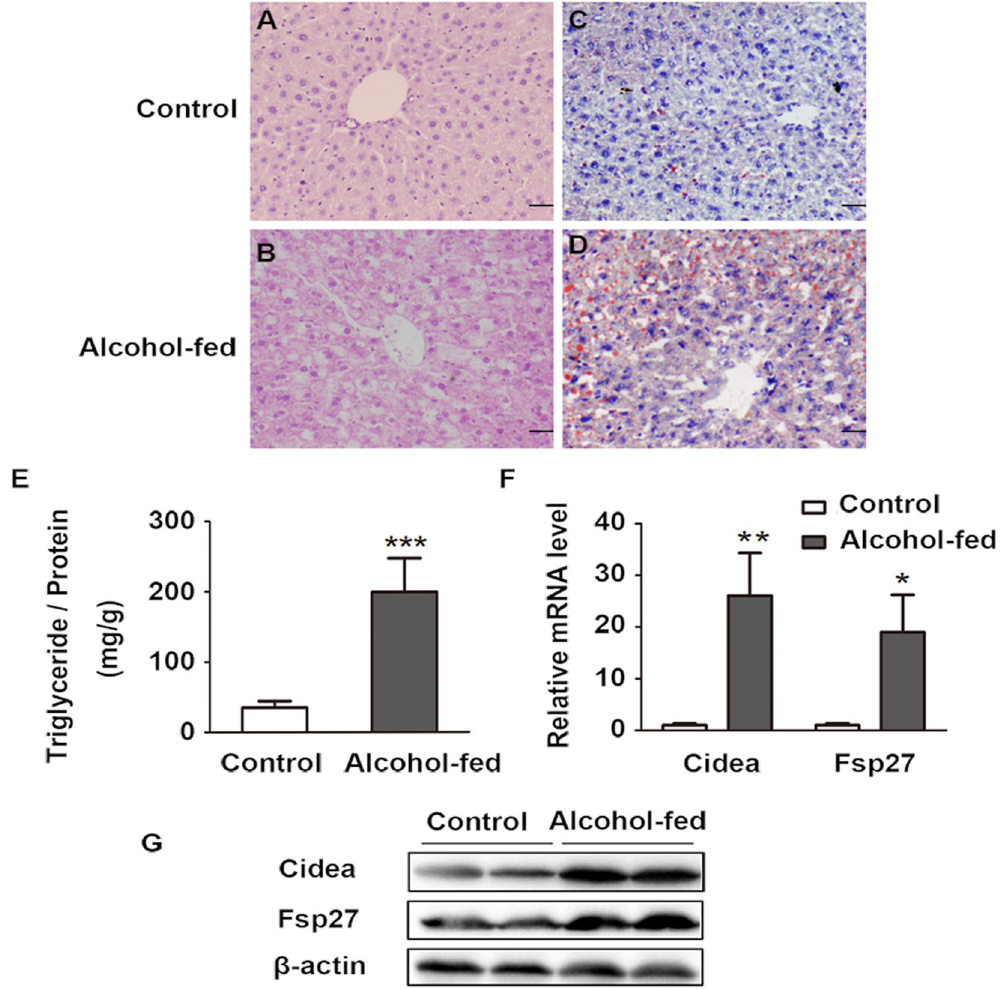
Figure 1. Increased hepatic Cidea expression in alcohol-induced fatty liver in mice. ( A , B ) Sections of the liver from control group and alcohol-fed mice were subjected to H&E staining and analysis using OLYMPUS FSX100 with a 200 × objective. ( C , D ) Oil red O-stained liver sections (X200). ( E ) Total Triglycerides level were detected from liver tissue. Means ± SD, n = 4–5 mice per group, *** p < 0.001 vs. control group. ( F ) Relative Cidea and Fsp27 mRNA levels in control group and alcohol-fed mice. Means ± SD, n = 4–5 mice per group, ** p < 0.01, * p < 0.05 vs. control group. ( G ) Cidea and Fsp27 protein levels in the liver tissue, full-length blots are presented in Supplementary Figure